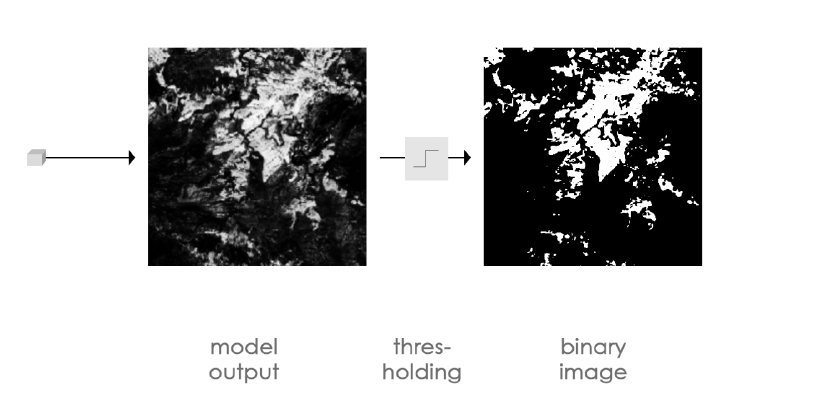
Figure 4. Model output showing the probability of each pixel being covered with Eucalyptus trees. The probability is represented as a grayscale value from 0 (black) to 1 (white). In the thresholded binary image, the two classes “Eucalyptus” and “Not-Eucalyptus” are displayed as white and black